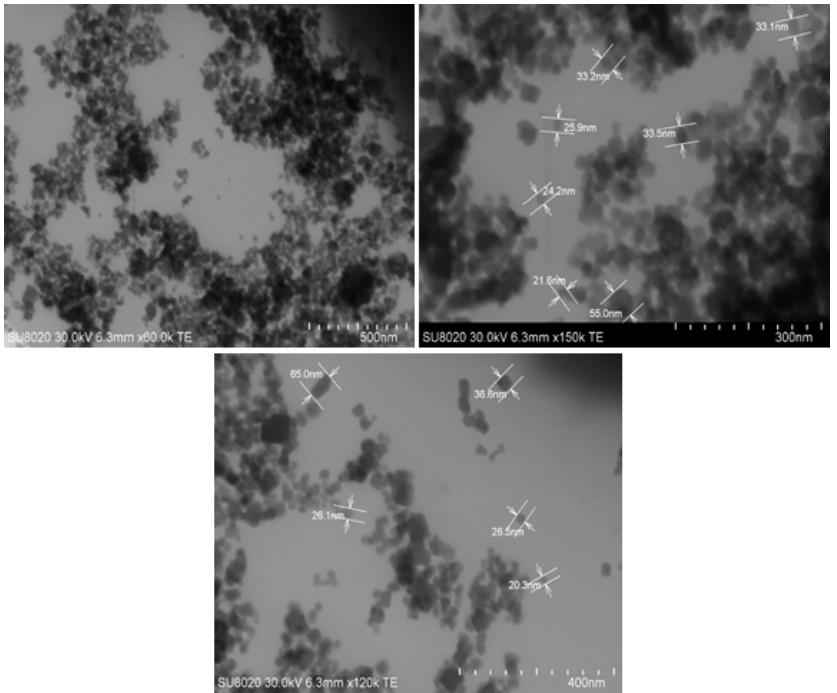
Figure 2. TEM micrographs of AHP nanoparticles obtained by milling.